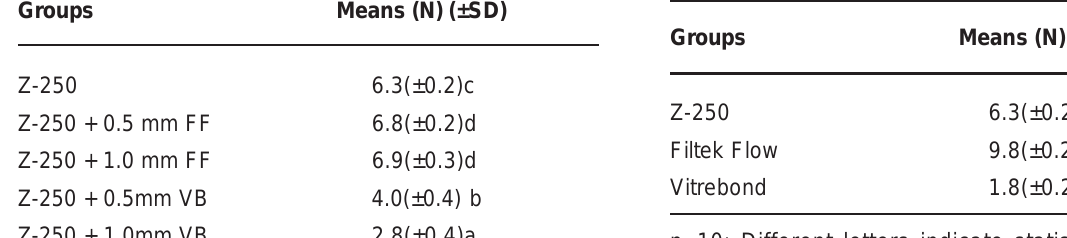
TABLE 1- Means (±SD) and statistical analysis of the polymerization contraction forces of the composite resin with or without intermediate materials